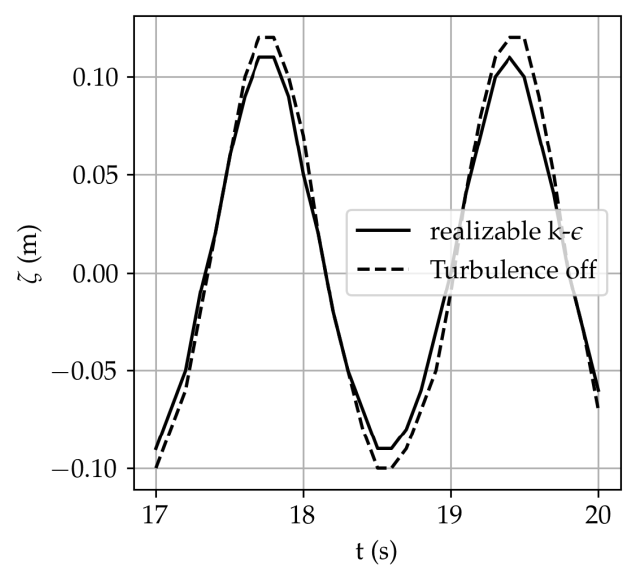
Figure 6. Influence of realizable k- ε turbulence model on wave height dissipation at wave gauge at LPP , after 10 oscillation periods and for N = 8.